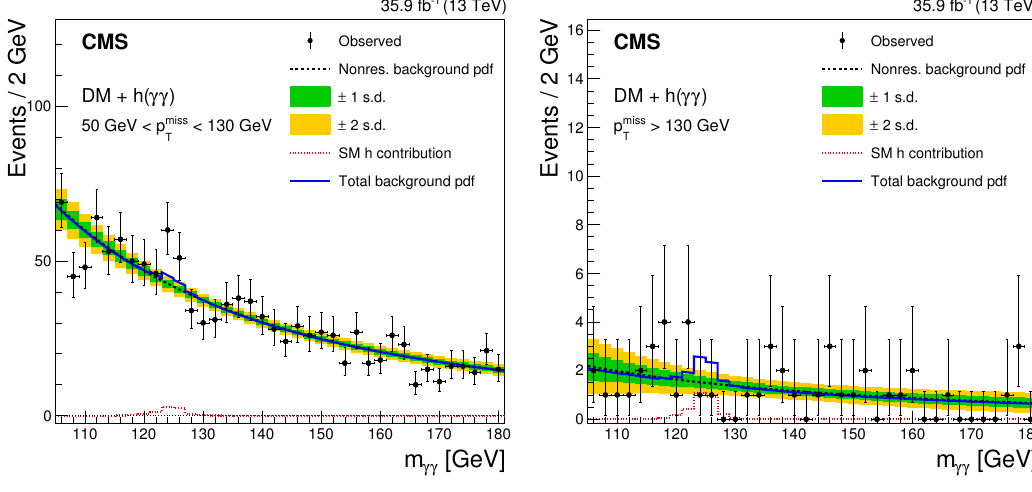
(left) and high- p miss (right) T T